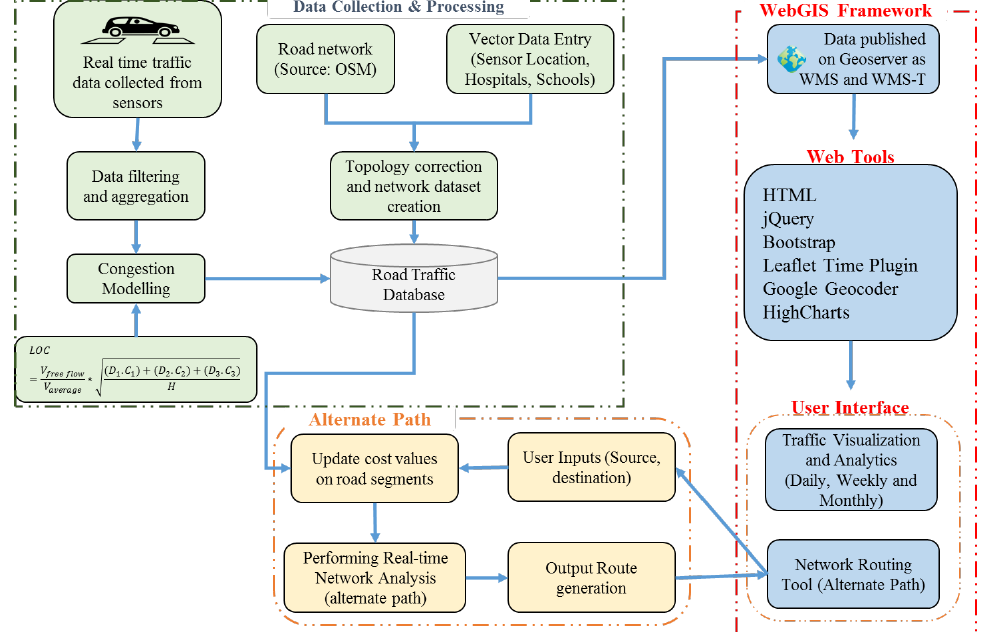
Figure 9. Methodological Flow Chart of WebGIS based real Time